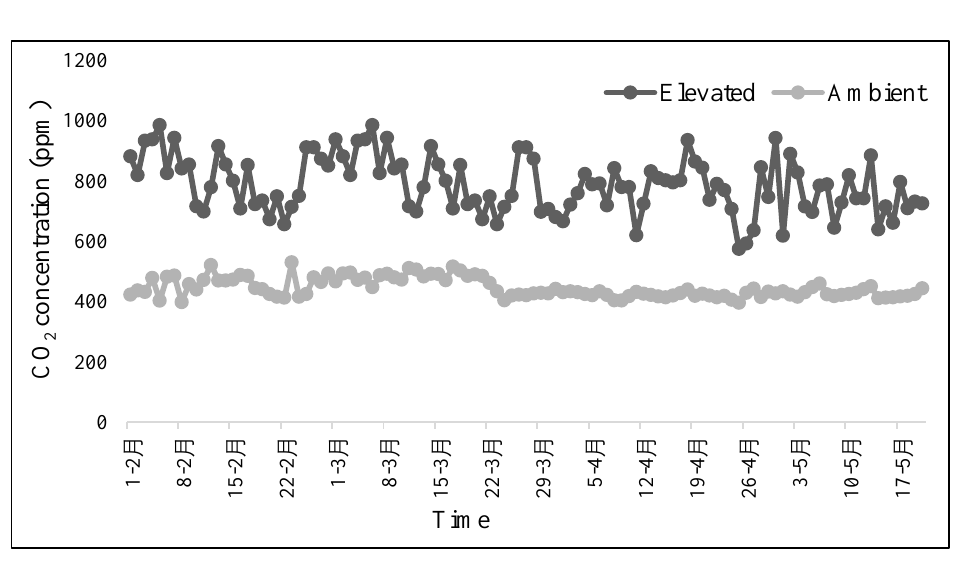
Figure 1. Average daily value of ambient and supplemental CO 2 concentration measured at Oklahoma State University (OSU) Department of Horticulture and Landscape Architecture Research Greenhouses (Stillwater, OK, USA) during the study period (average of 2016 and 2017).